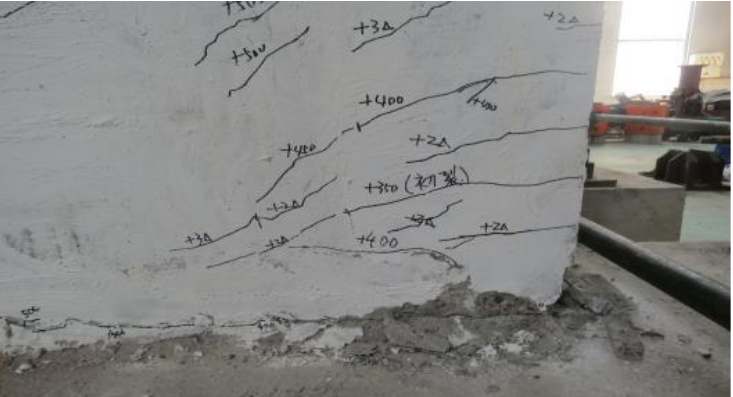
Figure 17. Vertical opening displacement of the contact surface between the wall pier and the base of the fabricated ECC/RC combined shear wall.